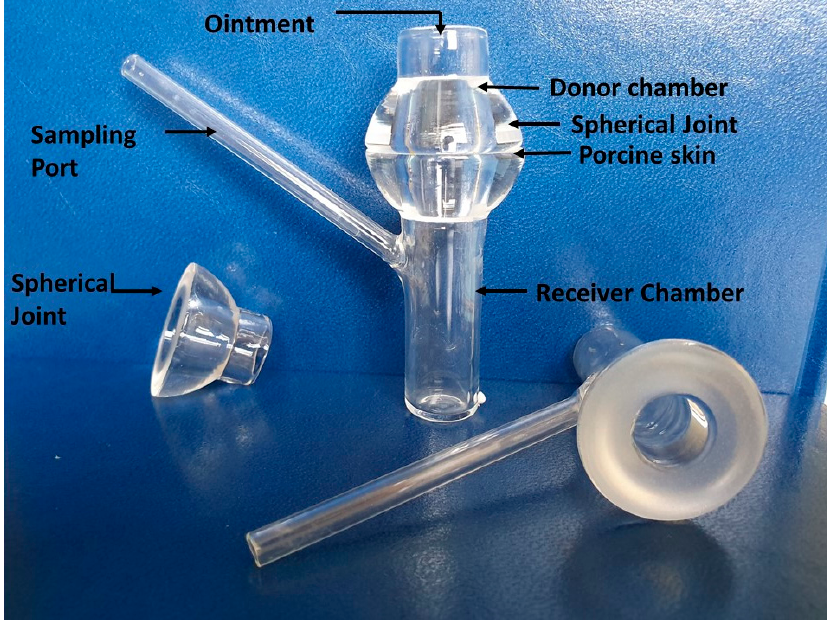
Figure 7. In vitro ACTH permeation study with porcine ear skin mounted on the vertical Franz cell with a spherical joint.